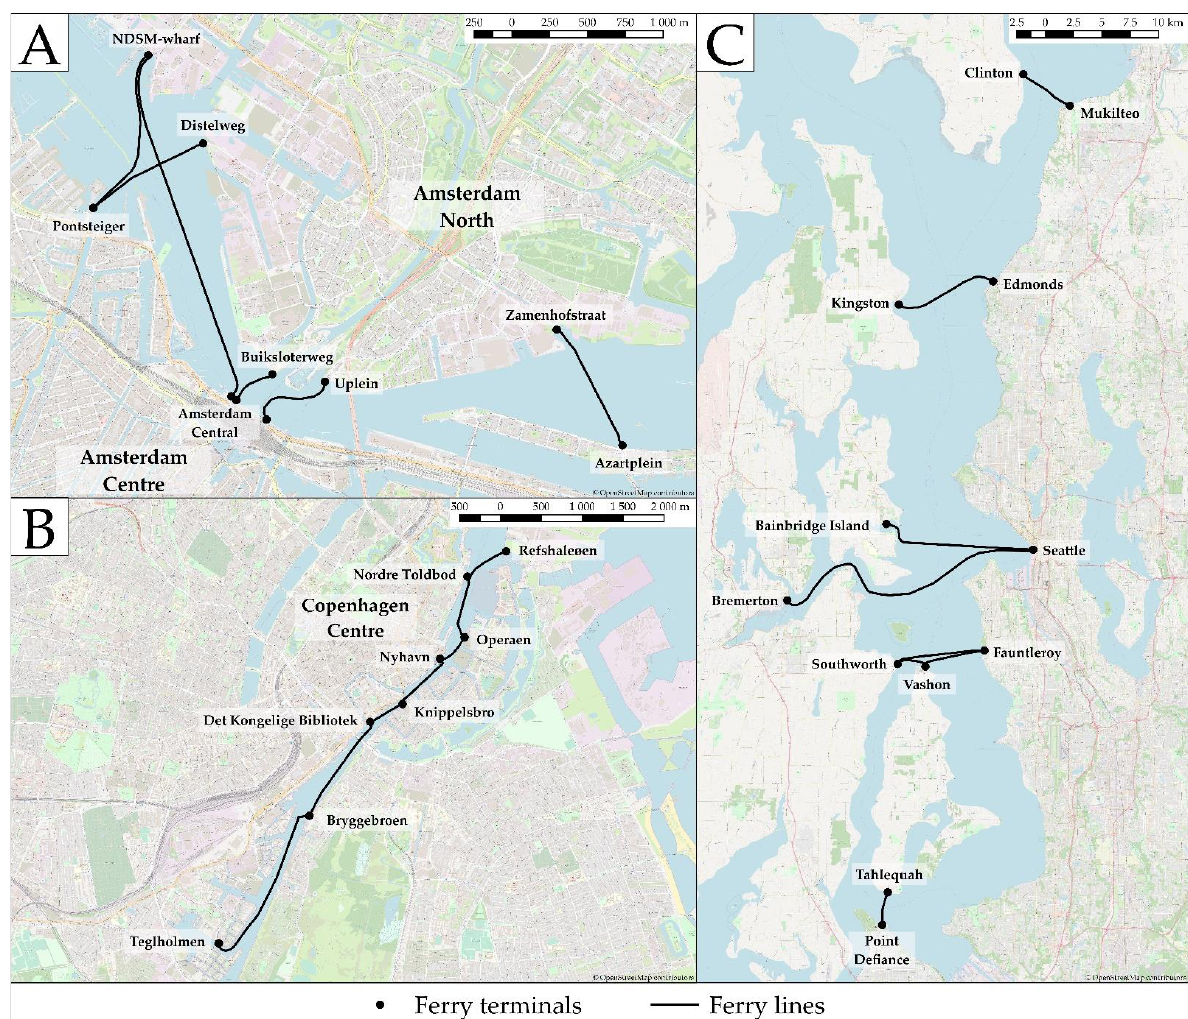
Figure 4. Types of ferry routes: ( A ) Amsterdam, ( B ) Copenhagen, ( C ) Seattle. Source: own elaboration based on Open- StreetMap data [65].